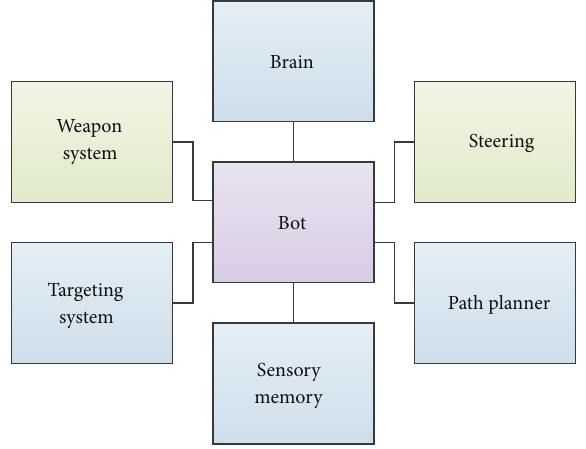
Figure16:OverviewoftheRavenbotAIstructure.Concreteactions such as firing a weapon or applying a steering force are taken by the green